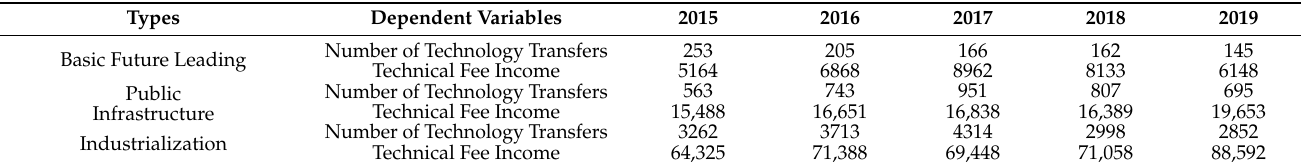
Table 9. The results of statistical analysis by GRI mission type (2015–2019).